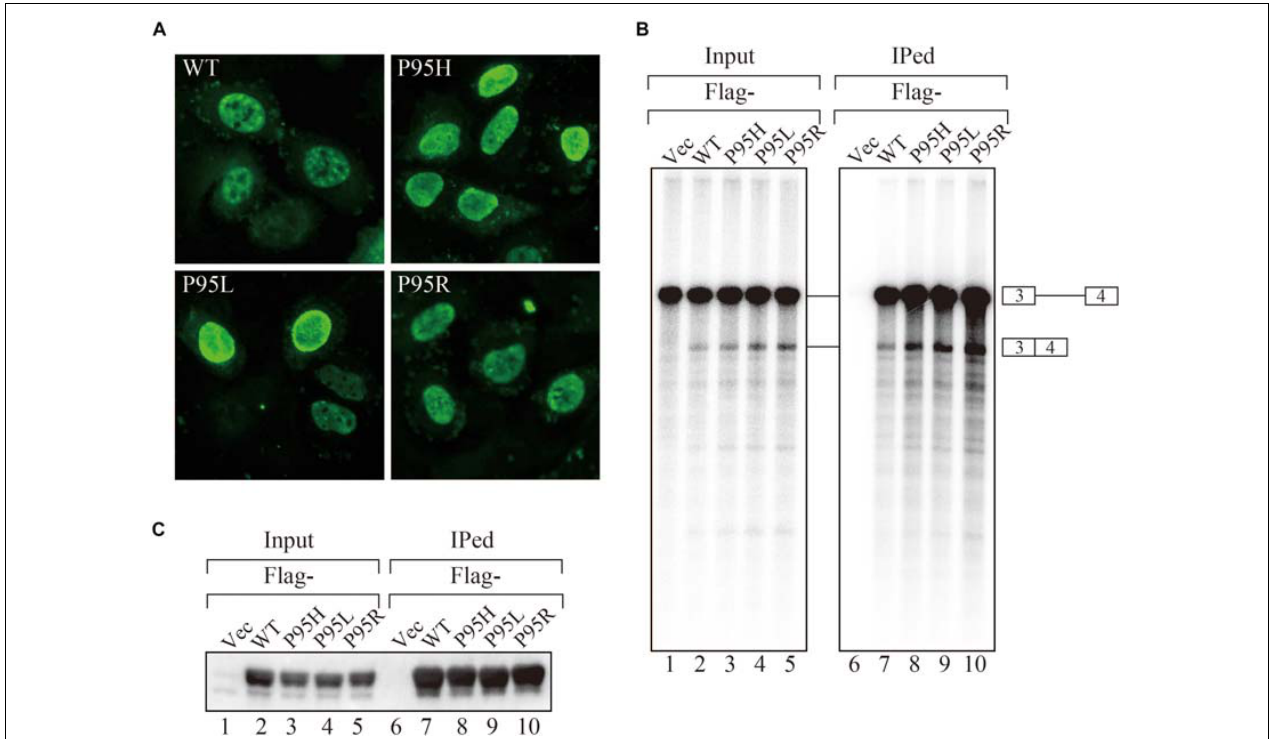
FIGURE 1 | MDS-causing SRSF2 mutant proteins are localized in the nuclei and associate with pre-mRNA and mRNA in vitro . (A) HeLa cells were transfected with expression vectors encoding either wild-type or mutant SRSF2 proteins (P95H, P95L, and P95R) fused with myc-tag. (B) In vitro splicing reaction in the presence of either Flag-tagged wild-type SRSF2 protein or mutant proteins followed by immunoprecipitation of RNAs by anti-Flag M2 antibody. (C) Immunoprecipitation of SRSF2 proteins by anti-Flag antibody from in vitro splicing reaction. Five percent of total reaction mixture was used as an input. The anti-Flag M2 antibody was used for detection of Flag-tagged SRSF2